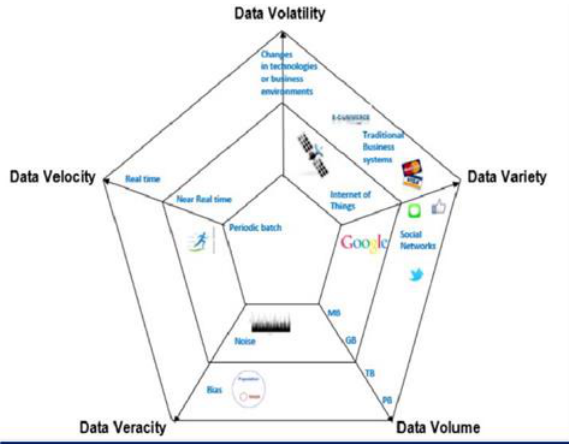
Figure 1: Elements of BIG-DATA. Source: Cornelia L. Hammer, Diane C. Kostroch,Gabriel and STA Internal Group,” Big Data: Potential, Challenges, andStatistical Implications”.IMF, September